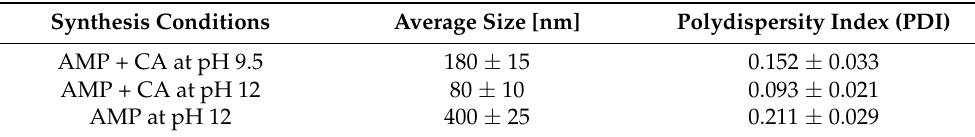
Table 1. Dependence of average size and polydispersity index for the dispersion of Ni NPs on synthesis